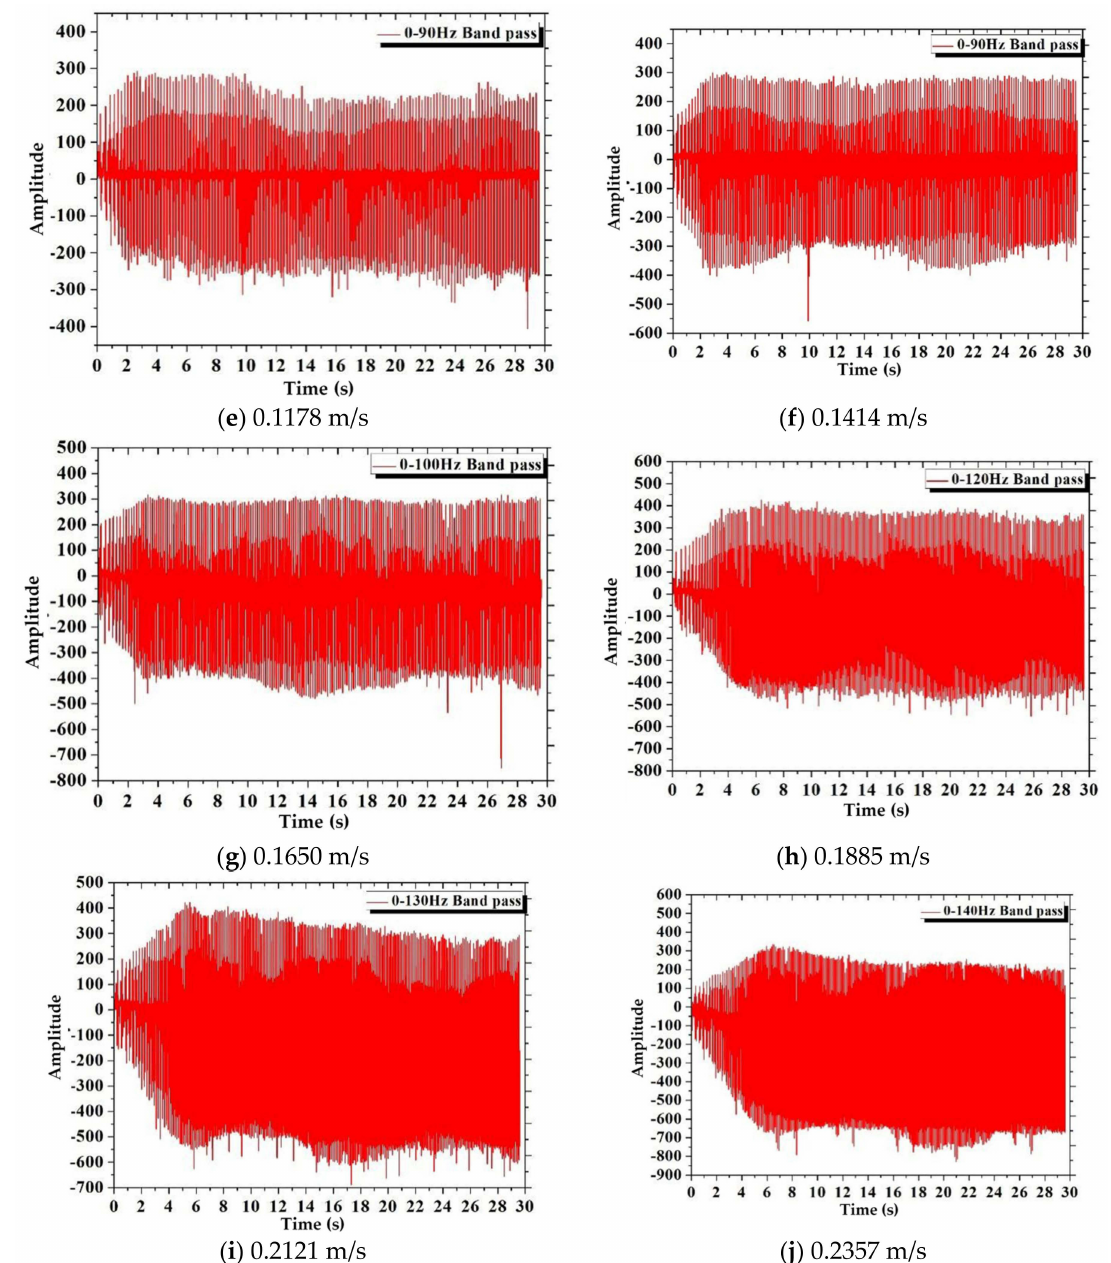
Figure 6. Vibration signals of 10 groups under different chain